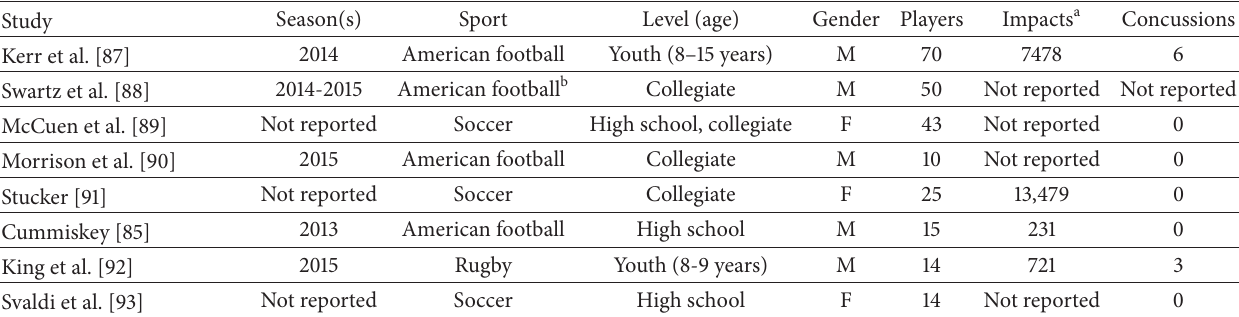
Table 2: X2 X-Patch studies of athletes during training and